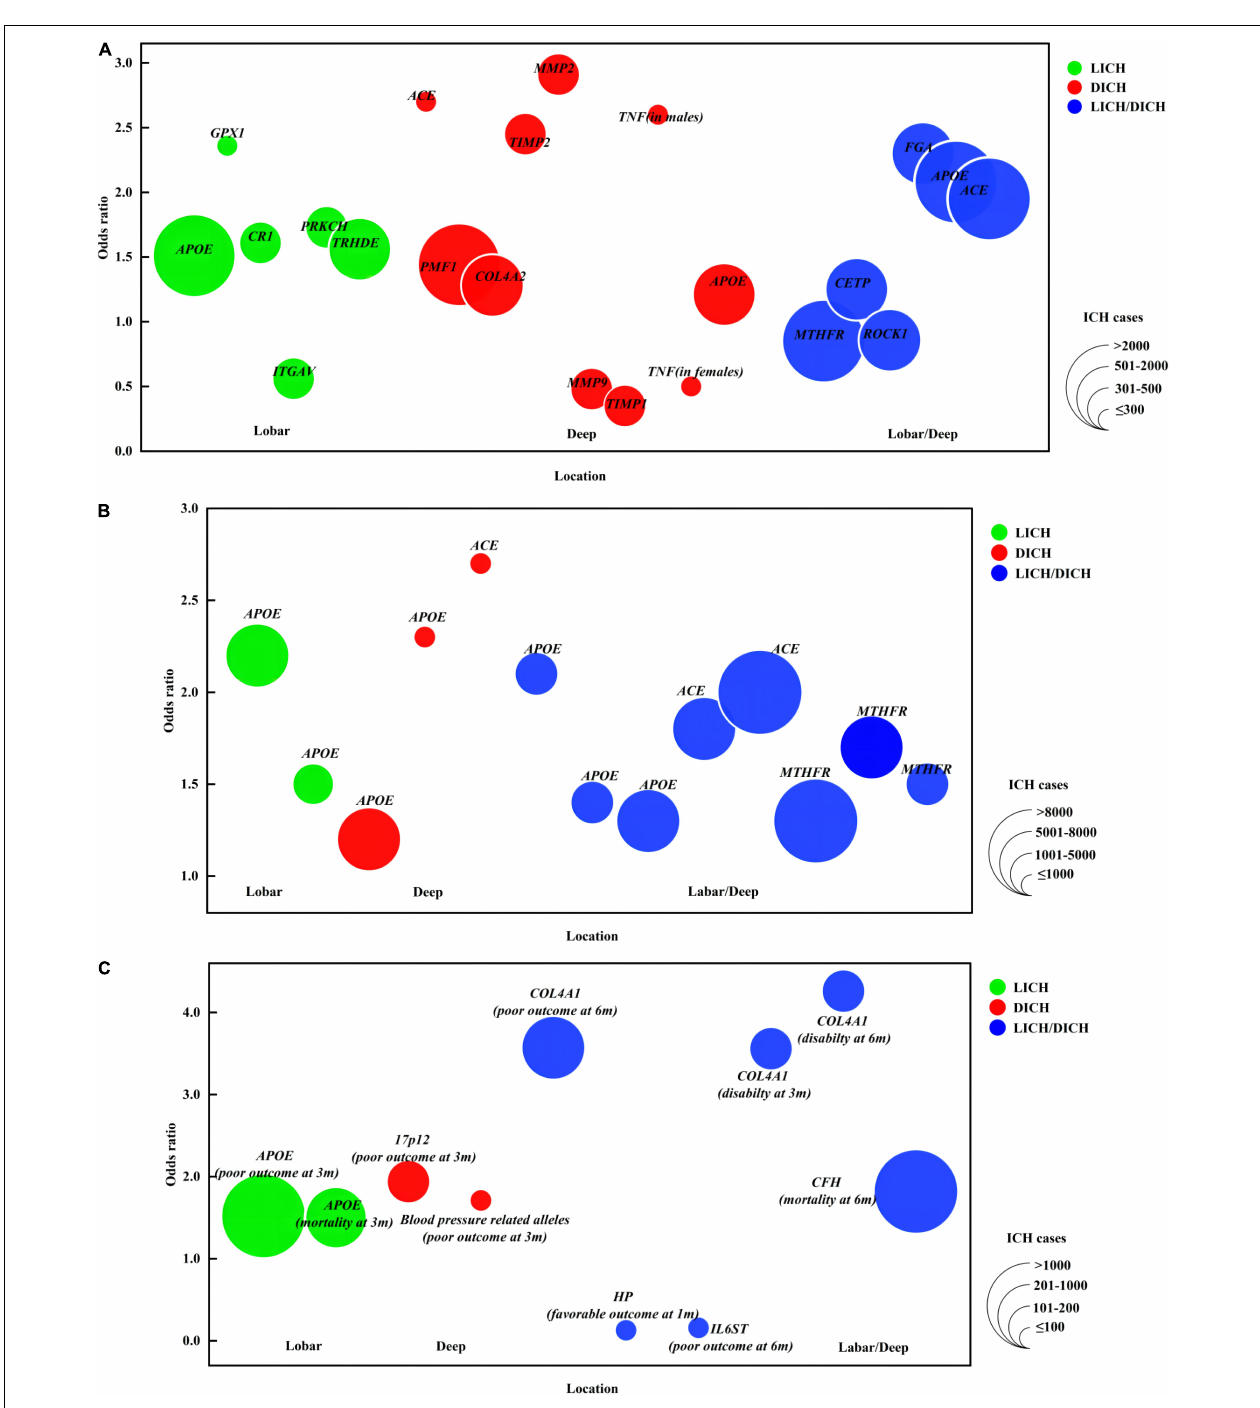
FIGURE 1 | Genetic loci for intracerebral hemorrhage. Colors indicate ICH location. The size of bubbles indicates ICH population. If OR is derived from several variants within one gene or from different genetic models, the OR farthest from 1 is represented here. (A) (1) The X -axis indicates ICH location. (2) The Y -axis provides OR of gene variants associated with ICH risk. (B) (1) The X -axis indicates ICH location. (2) The Y -axis provides OR of gene variants associated with ICH risk replicated in multiple studies/populations. (C) (1) The X -axis indicates ICH location. (2) The Y -axis provides OR of gene variants associated with ICH outcome. APOE , apolipoprotein E; GPX1 , glutathione peroxidase 1; CR1 , complement C3b/C4b receptor 1; ITGAV , integrin subunit alpha V; PRKCH , protein kinase C eta; ACE , angiotensin I converting enzyme; COL4A2 , collagen type IV alpha 2 chain; TIMP , tissue metalloproteinase inhibitor; MMP , matrix metalloproteinase; TNF , tumor necrosis factor; MTHFR , methylenetetrahydrofolate reductase; CETP , cholesteryl ester transfer protein; ROCK 1, Rho associated coiled-coil containing protein kinase 1; FGA , fibrinogen alpha chain; HP , haptoglobin; IL6ST , Interleukin 6 cytokine family signal transducer; COL4A1 , collagen type IV alpha 1 chain; CFH , complement factor H; 3/6 m, 3/6 months. Disability (mRS, 3–5); death (mRS, 6); poor outcome (mRS, 3–6); favorable outcome (mRS, 1–2).